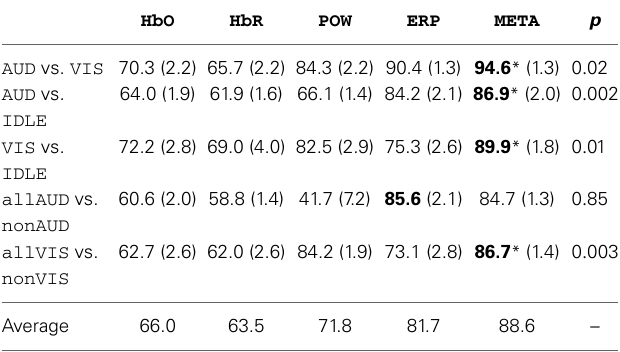
Table 3 | Stimulus-locked classification accuracies (in %) for subject-independent classification.